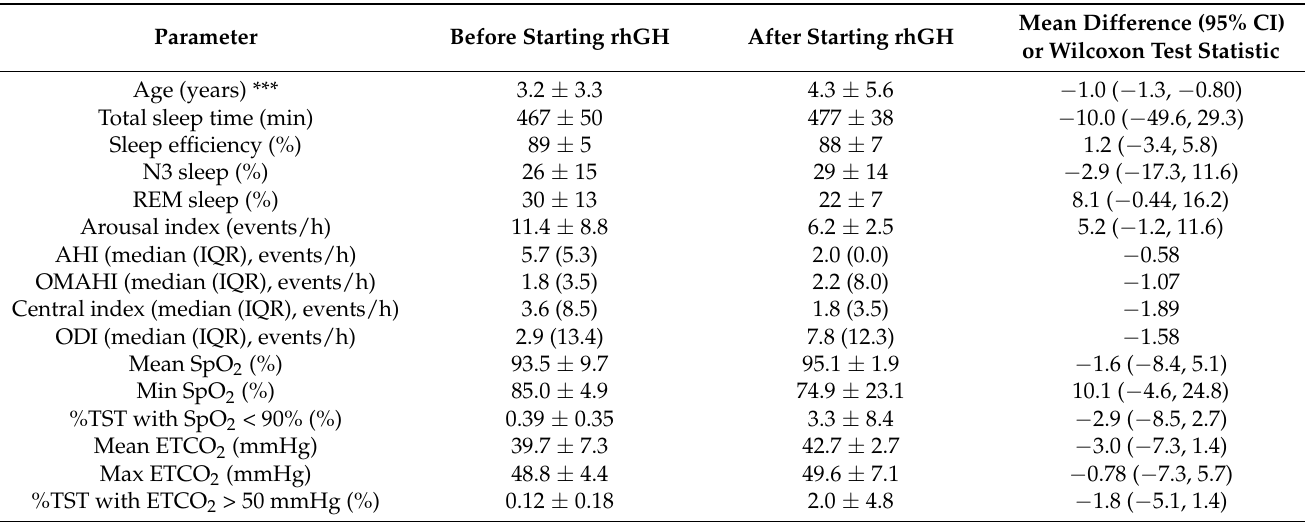
Table 4. Comparison of polysomnography results before and after initiation of recombinant human growth